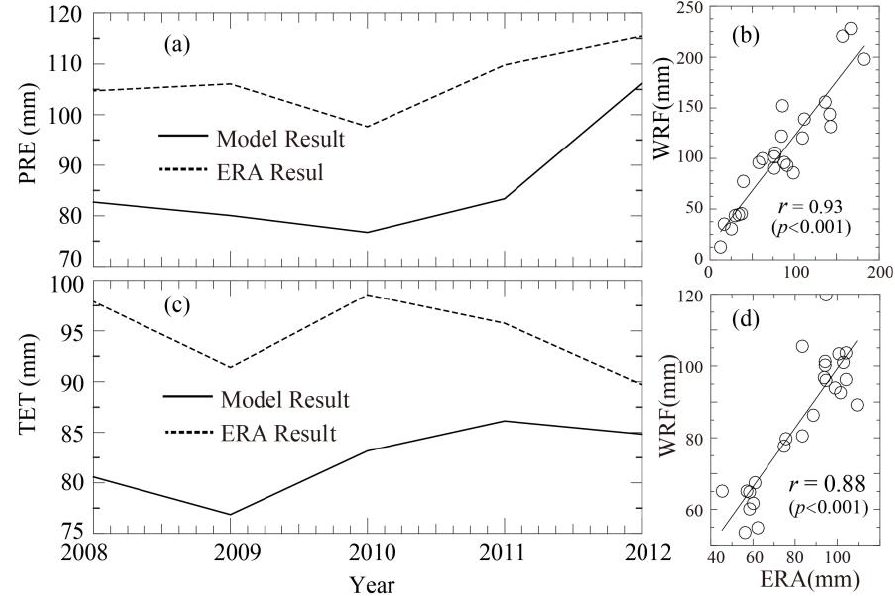
Figure 4. Comparison of the Weather Research and Forecasting (WRF) simulated and European Reanalysis (ERA) Reanalysis of precipitation ( a ) and total evapotranspiration ( c ) in 2008–2012. ( b – d ) are scatterplots of precipitation ( PRE ) and total evapotranspiration ( TET ), respectively. Assuming the ERA Reanalysis as truthing data in the period from 2008 to 2012, Figures 4 and 5 indicate that the WRF model successfully extracted the spatial patterns and temporal dynamics of the land-atmosphere process in the study region. It was then used to examine the centurial dynamics of water balance following the intensive agricultural